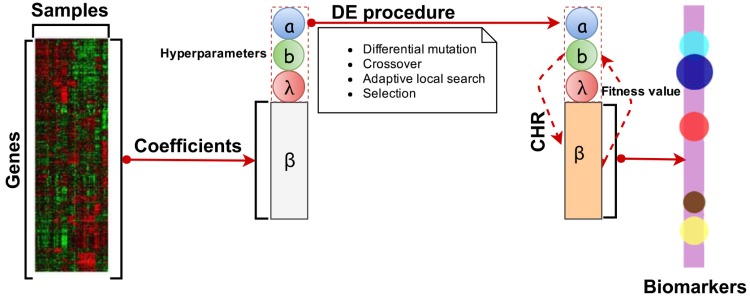
The workflow of our proposed the complex harmonic regularization with differential evolution algorithm (CHR-DE) for selecting biomarkers.Microarray gene expression data for one certain cancer are collected, processed into a matrix file that contains the genes (rows) and tissue samples (columns). In order to identify tumor subclasses that are both biologically meaningful and clinically relevant, we apply the differential evolution (DE) to fine tuning the hyperparameters of the complex harmonic regularization (CHR). After the operations of DE procedure, such as differential mutation, crossover, adaptive local search and selection, this CHR can be used in the learning procedures, and then give the fitness values feedback to update its hyperparameters. With a fully trained model, we can get some groups of genes with non-zero coefficients, which may be the valid biomarkers for this cancer.